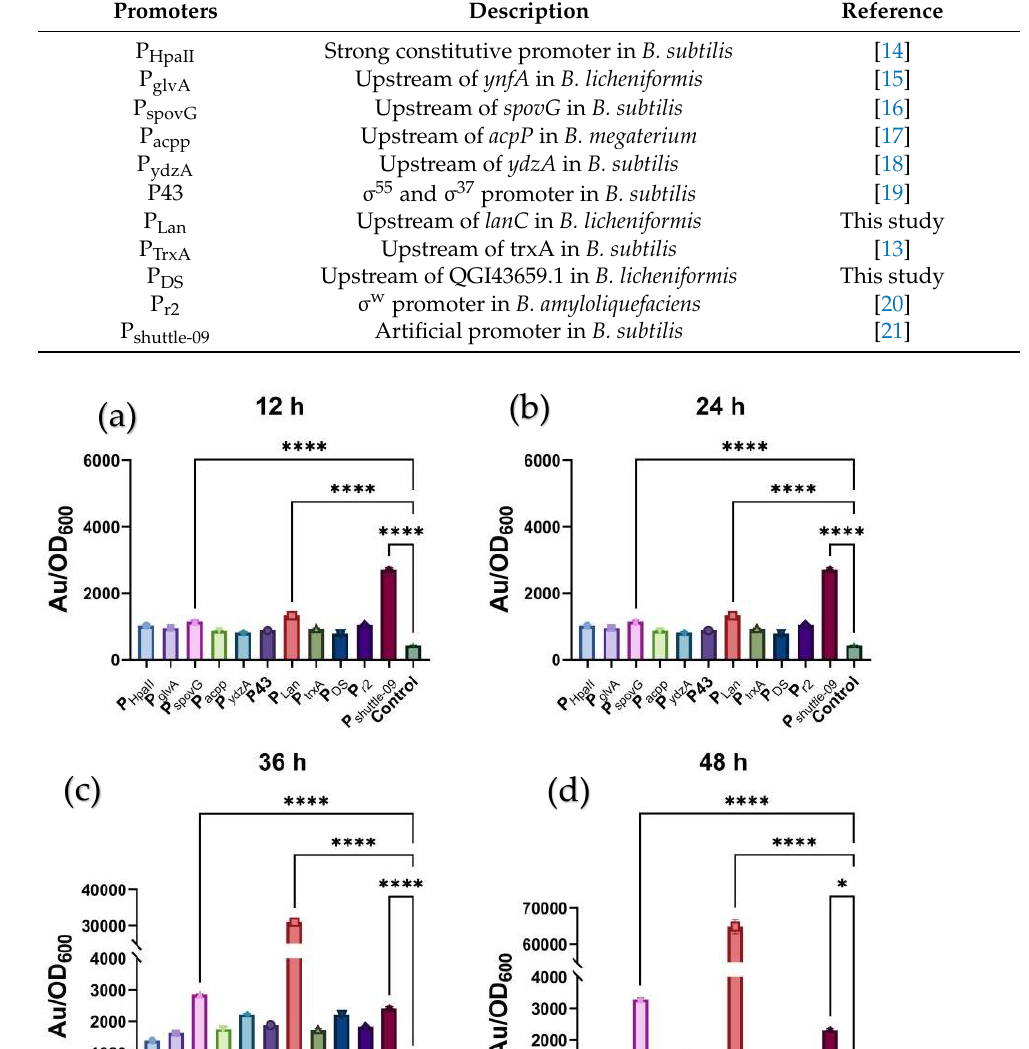
Table 1. The selected promoters of Bacillus origin.